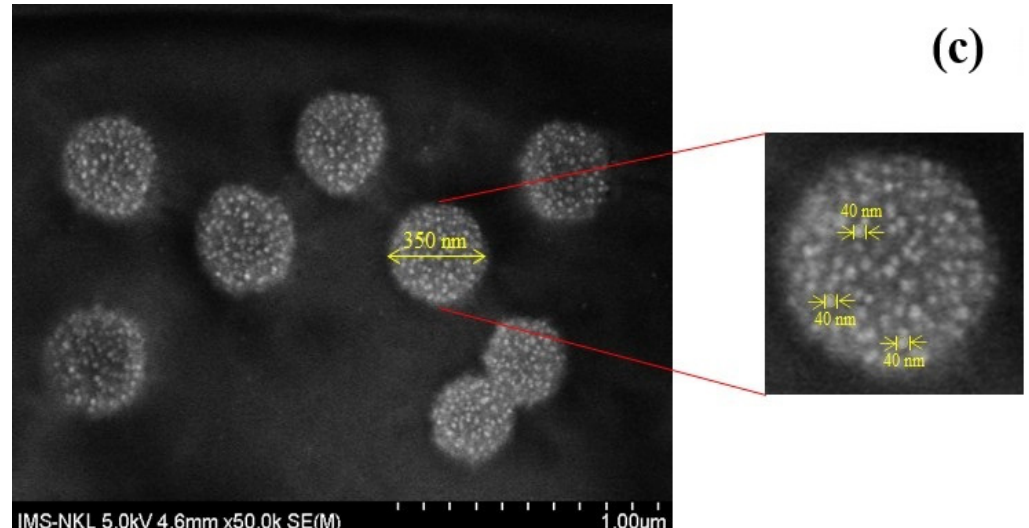
Figure 6. SEM images of SiO 2 ( a ), SiO 2 @PEI ( b ), and SiO 2 @Au ( c ). According to the DLS results of SiO 2 and SiO 2 @Au shown in Figure 7, the size of SiO 2 particles ranges from 260 to 360 nm, and the average size of SiO 2 particles is about 316 nm. Similarly, the average size of SiO 2 @Au particles is approximately 582.4 nm.